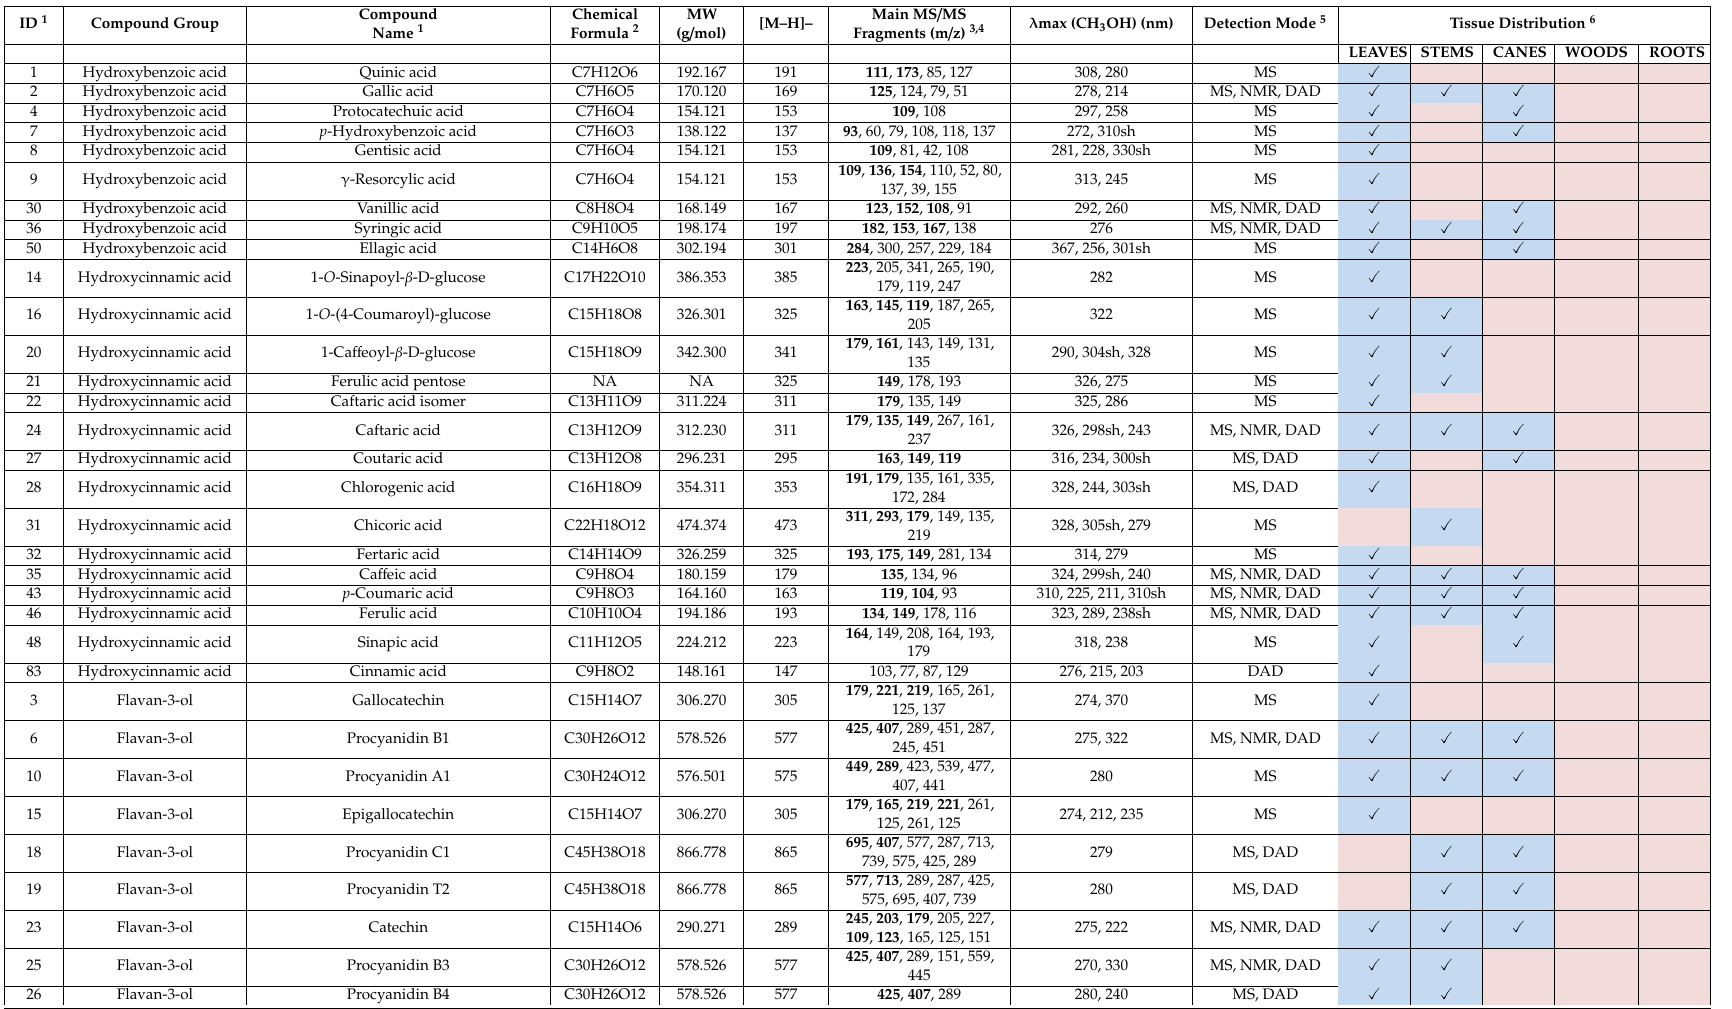
Table 1. Polyphenols (excluding stilbenes) in the vegetative organs of the grapevine